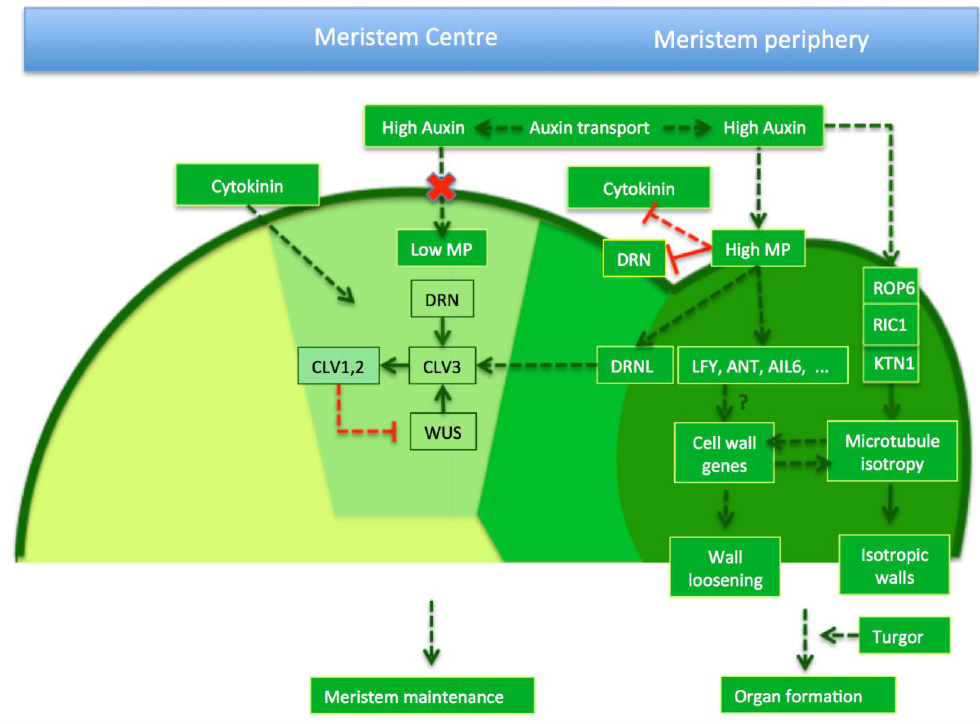
Figure 1. Molecular and cellular regulation of organ initiation at the periphery. Auxin transport generates auxin maxima at the meristem centre (light green area) and periphery (darker green), but since the centre is relatively insensitive to auxin (red cross), its effects seem to be limited and cytokinin driven meristem maintenance dominates. Auxin at the periphery causes wall loosening and cell isotropy. This involves both transcriptional and cellular responses. Depending on their wall properties, cells will then grow at particular rates and in particular directions, driven by turgor pressure. Dotted arrows represent indirect effects, solid lines direct, molecular relationships. Green arrows stand for positive control and red lines for